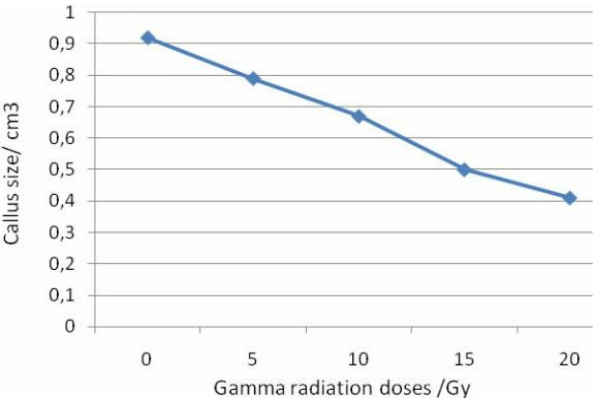
Shoot length cm / days Radiation